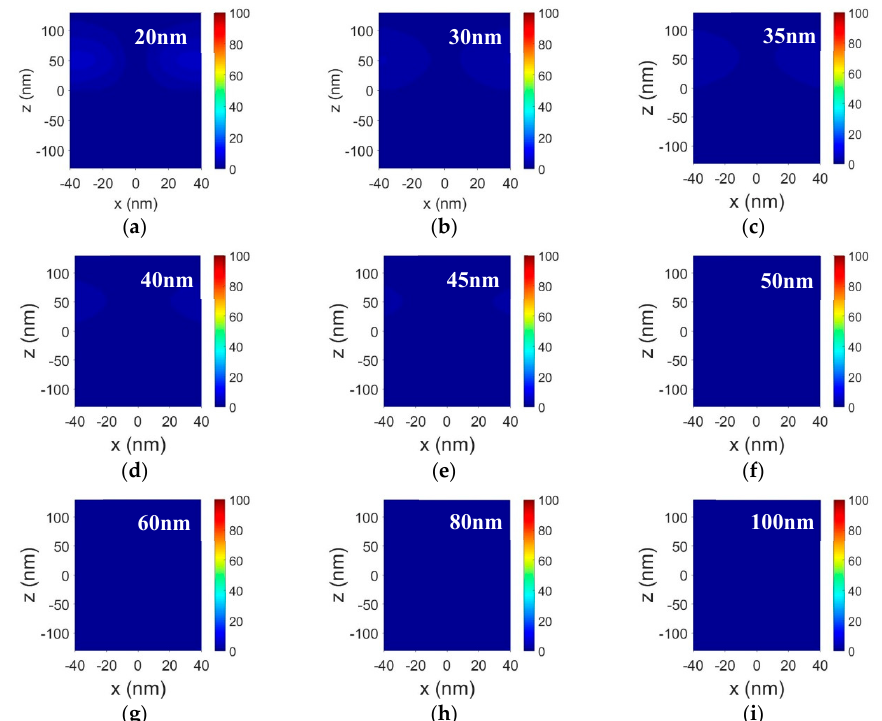
Figure 11. The electric field E(x, z) distributions of the silver nanorod on the SiO 2 substrate with a diameter of 30 nm and a length of 100 nm for the incident dipole source with the x-polarization direction. ( a − i ) Correspond to the monitor positions of y = 20, 30, 35, 40, 45, 50, 60, 80, and 100 nm.